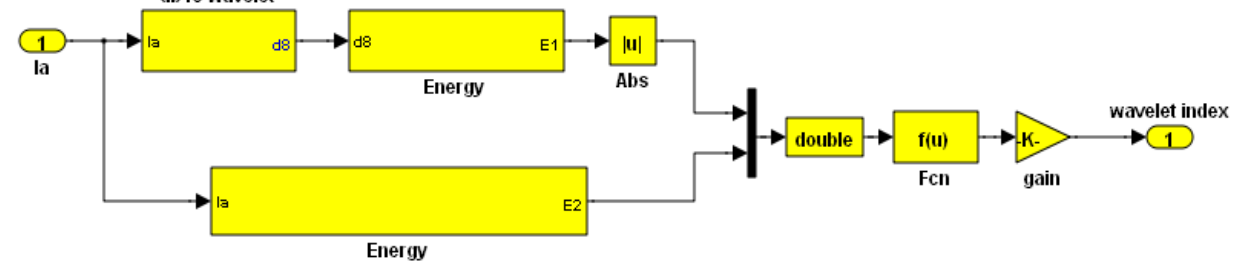
Figure 8. Simulink wavelet index implementation.